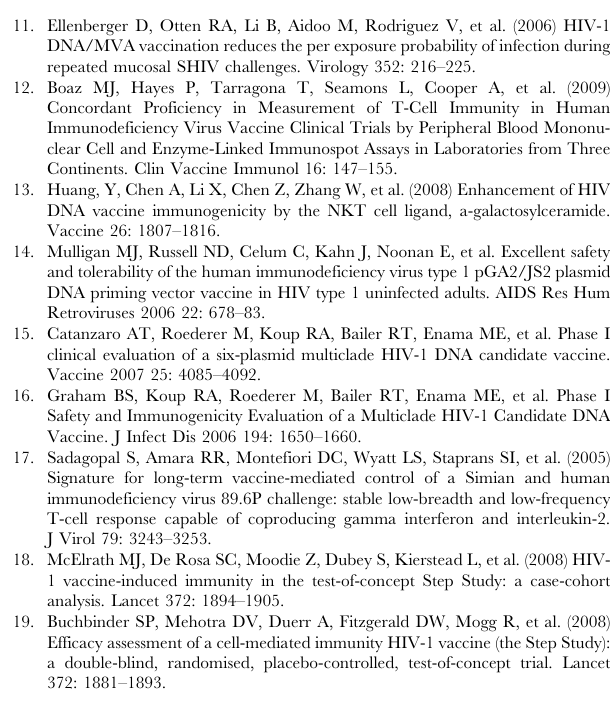
Table 3 summarizes the IFN c ELISpot response rate and magnitude in spot forming cells per million PBMCs (SFC) among volunteers receiving ADVAX by dose group. There were no positive responses in placebo recipients. The timing of IFN c ELISpot responses and distribution of antigens eliciting these responses are listed.